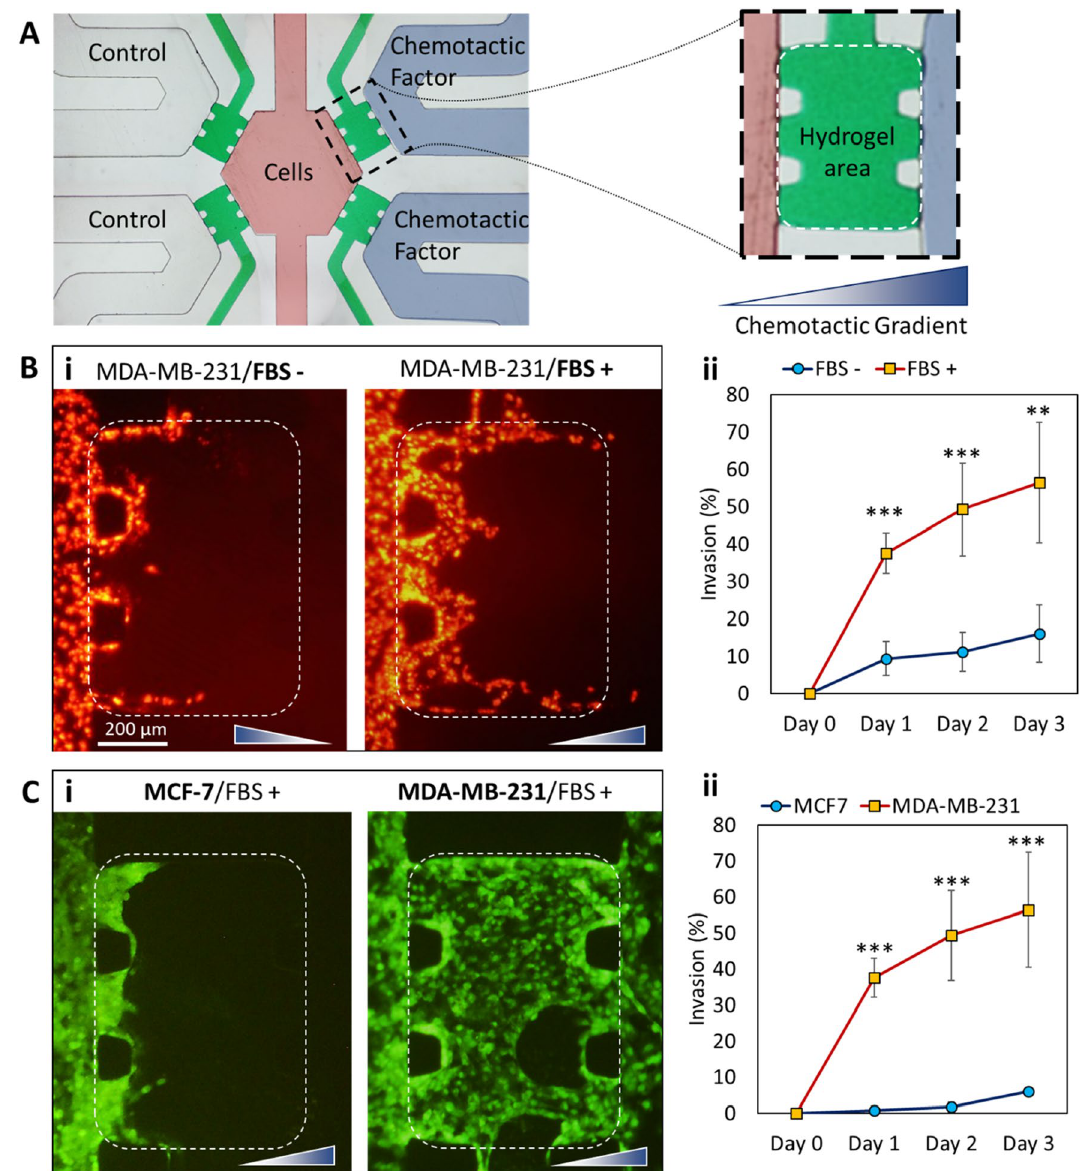
Figure 4. Investigating the invasion of different cancer cells in response to different chemotactic factors. ( A ) The border of hydrogel regions is indicated by dashed white lines. ( B ) MDA-MB-231 breast cancer cell invasion in response to additional FBS in signal channels, two days post-seeding. ( C ) Comparison of two breast cancer cell line invasiveness, using the proposed microfluidic strategy, three days post-seeding. In both ( B ) and ( C ) subfigures, representative images are shown in (i) while the quantitative evaluations are shown in (ii). The direction of the gradient is shown by triangular gradient shape at the bottom-right of each image. ***P <